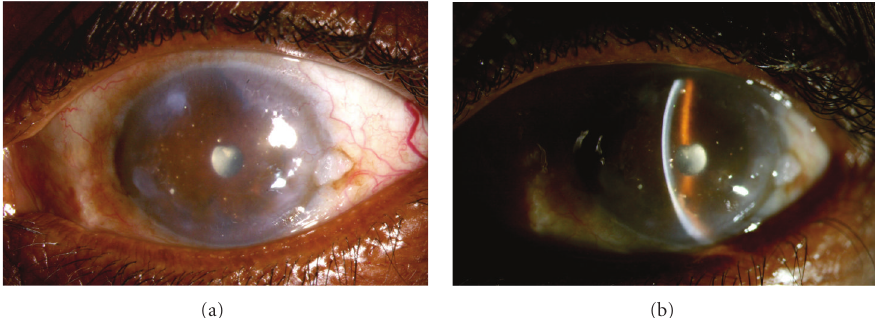
Figure 1: A 54-year-old farmer gave history of loss of vision and repeated episodes of redness and pain in the left eye following injury 40 years ago. B scan of the left eye showed findings suggestive of old vitreous hemorrhage and retinal detachment. Since visual acuity was doubtful perception of light, surgery was not advised for him. Di ff use (a) and slit (b) photographs show the left eye with peripheral corneal scar and peripheral anterior synechiae and total posterior synechia with cataract. At the temporal periphery, there is an incidental conjunctival lesion suggestive of actinic keratosis. Note the polychromatic crystals (cholesterolosis) deposited on the